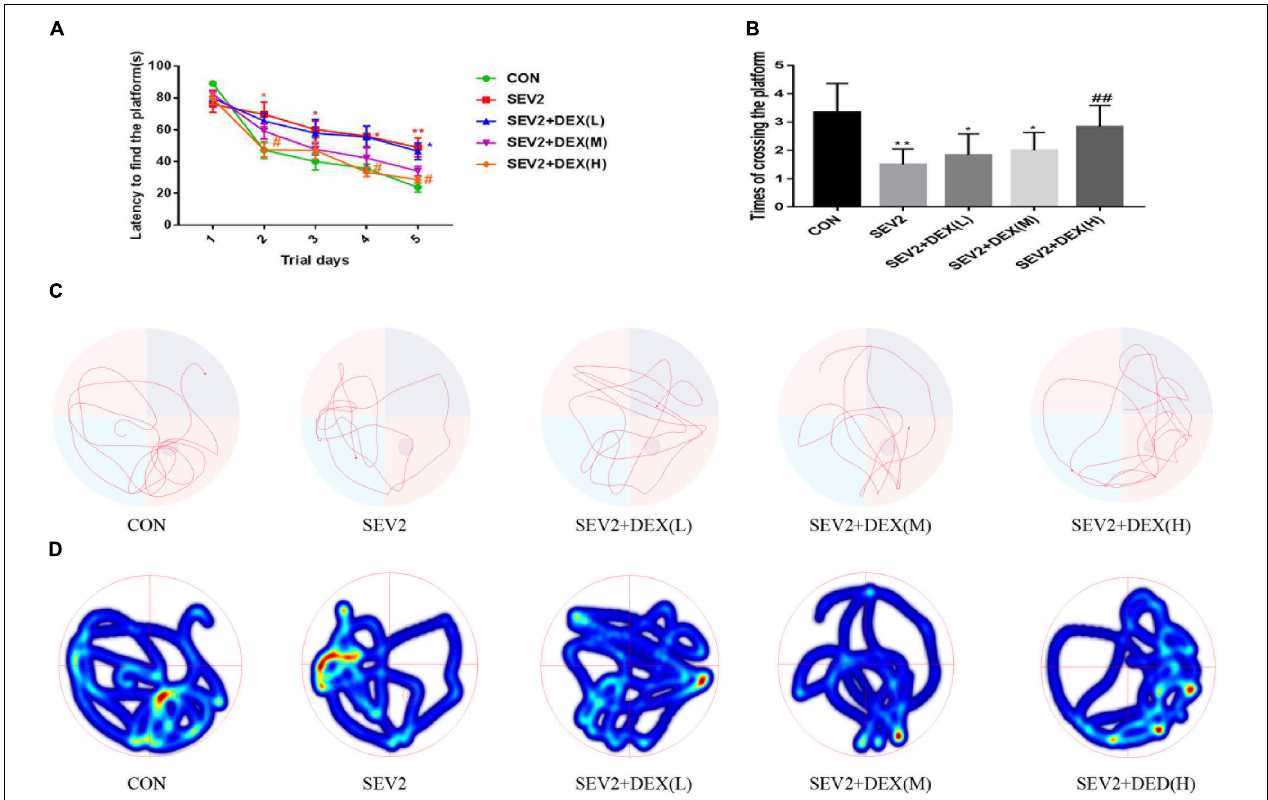
FIGURE 4 | Dex at 20 µ g/kg improved the cognitive dysfunction of juvenile offsprings induced by maternal sevoflurane exposure. The ability of learning and memory were evaluated using the Morris Water Maze (MWM) test from P28 to P33. Escape latency represented learning ability (A) , and platform crossing times indicated memory ability (B) in all groups. Two-way ANOVA repeated-measures followed by Bonferroni’s post hoc test were used to analyze the escape latency, and the times of crossing platform were analyzed by one-way ANOVA. Data are expressed as the mean ± SEM ( n = 8 in each group); ∗ P < 0.05, ∗∗ P < 0.01, compared to the CON group; # P < 0.05, ## P < 0.01, compared to the SEV2 group. Typical swimming patterns (C) and heat maps (D) showed the swimming path of the offspring on the 6th day of the MWM test.